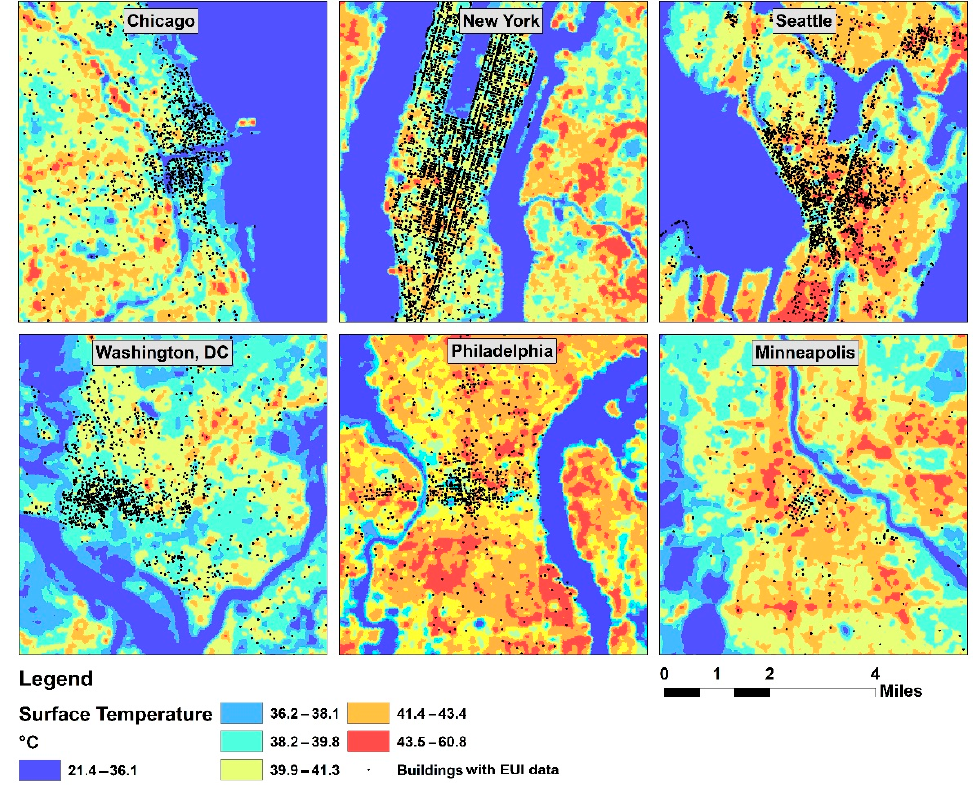
Figure 2. Surface temperature distribution (1 m 2 resolution). Table 1. Summary of building-type shares in different cities’